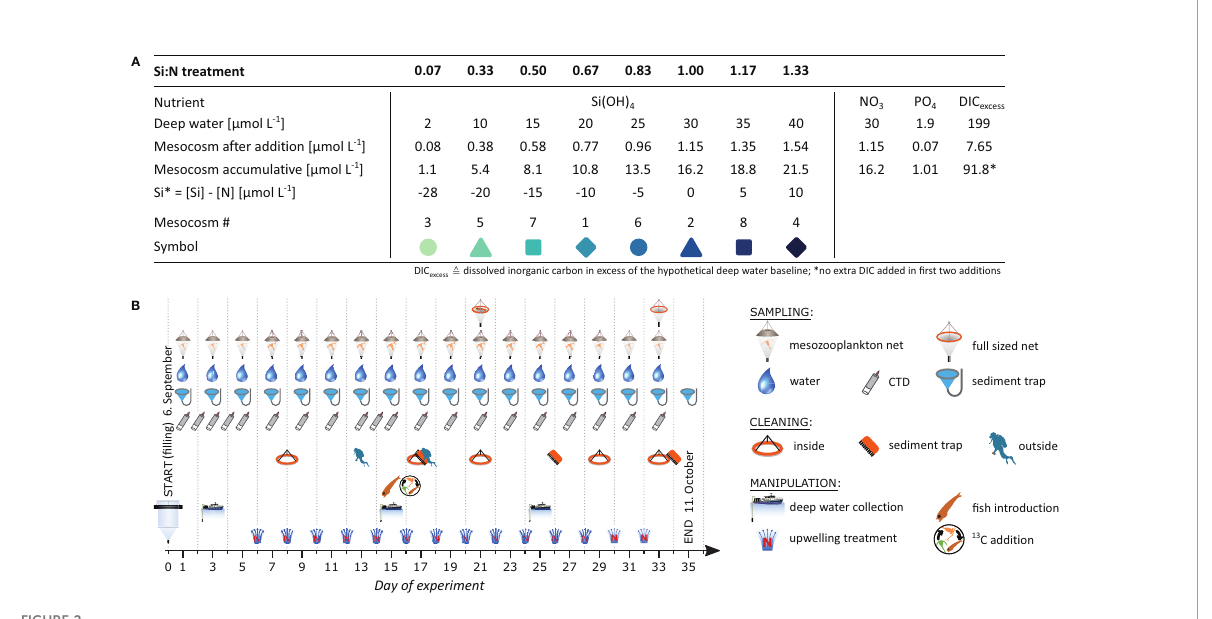
SPF60, Flexodamp FD-50) and mechanical fl ow meters. The natural plankton community was included, while larger organisms such as fi sh were excluded via a 3 mm mesh.